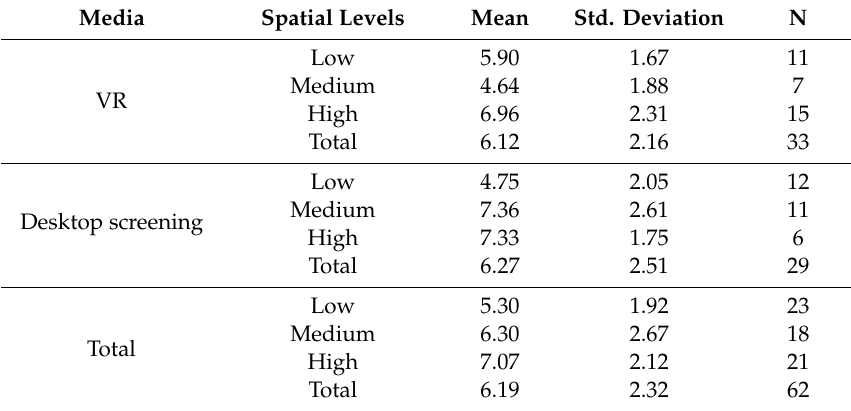
Table 3. Descriptive Statistics for Research Question 1.